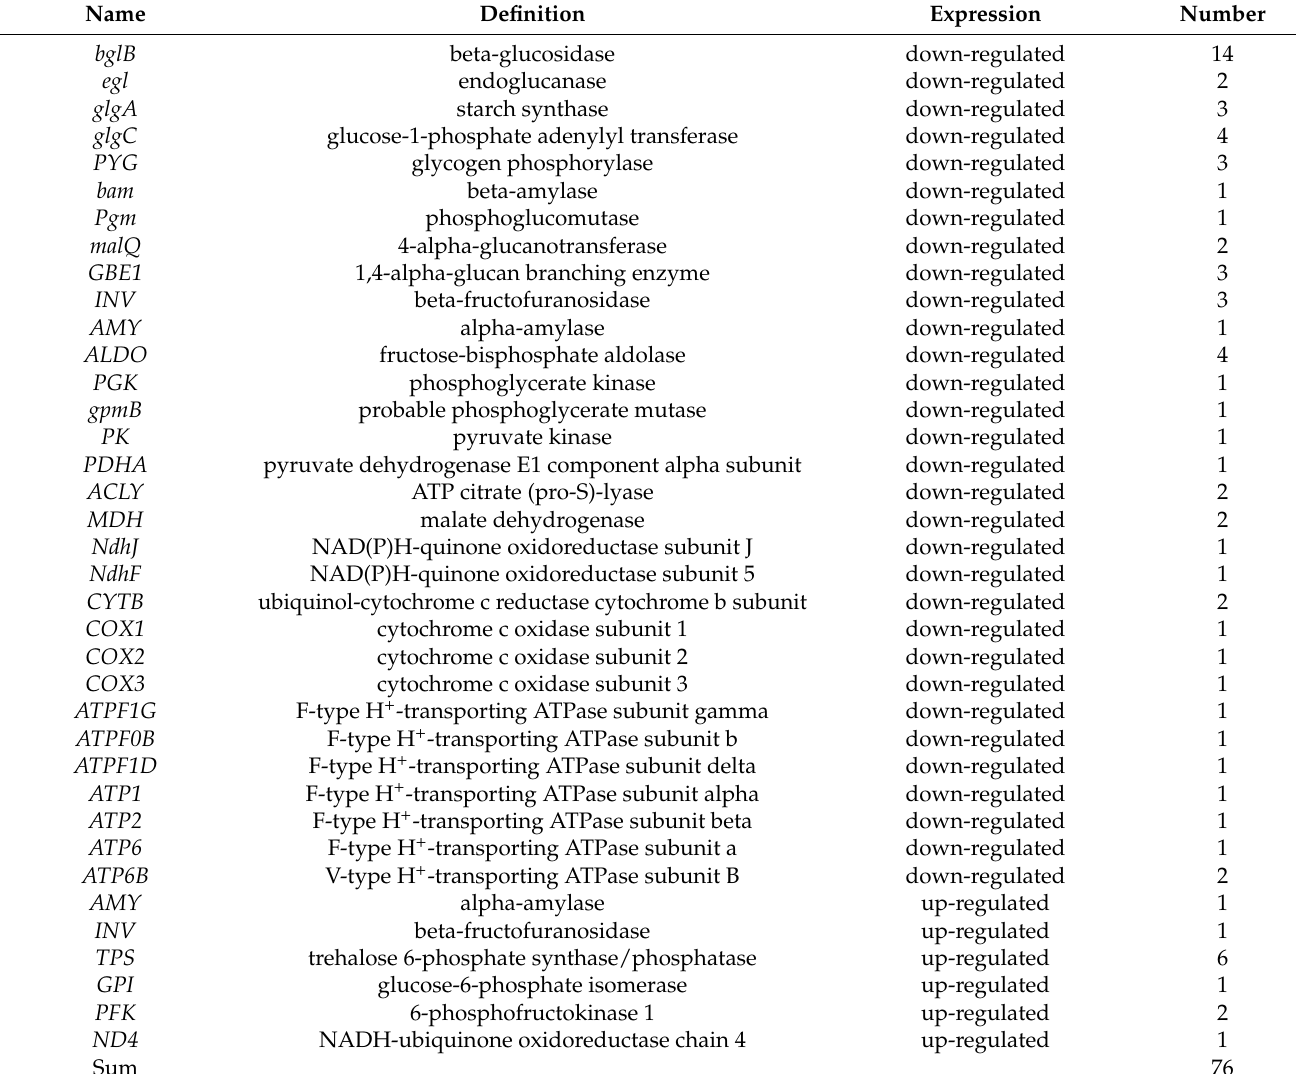
Table 2. The co-expressed differentially expressed genes (DEGs) related to energy metabolism in aboveground tissues of bermudagrass under shallow submergence (SS) and deep submergence (DS) for 7